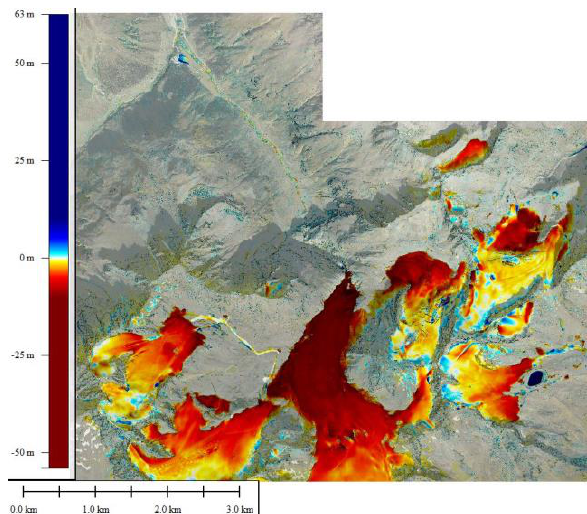
Figure 14. Retreat of the glaciers in Pitztal and Oetztal between 2010 and 2014. Maximal vertical melting is more than 50 m at the